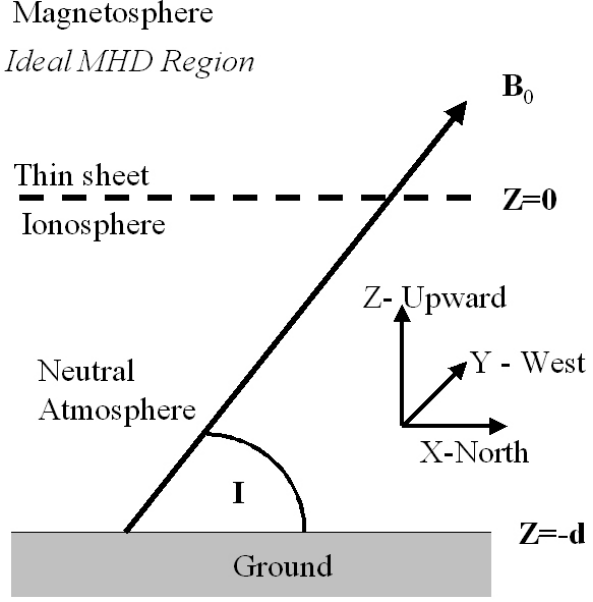
Fig. 1. Geometry of the magnetosphere, ionosphere and atmosphere used for the ULF wave propagation